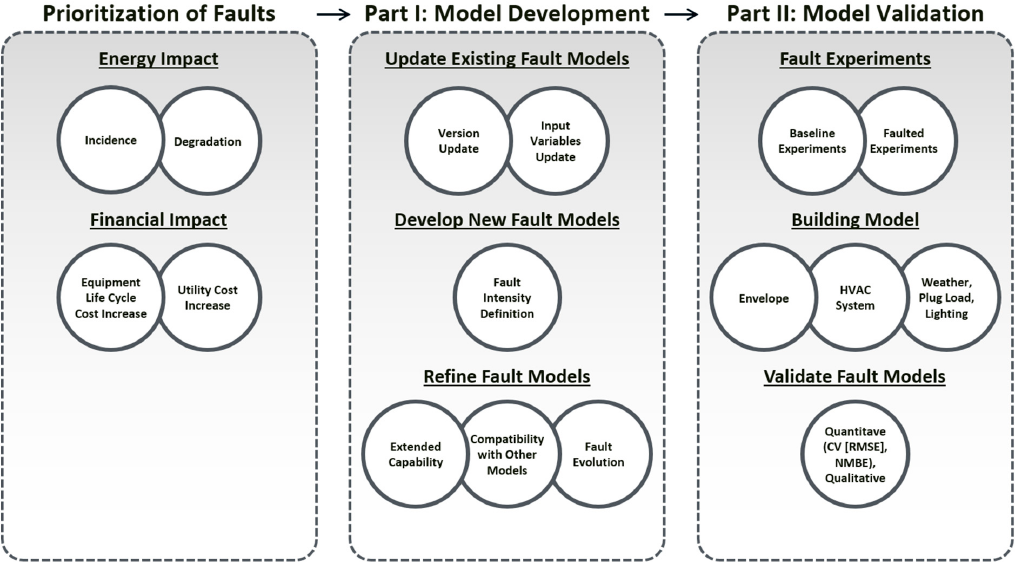
Figure 1. Overall workflow of this study.